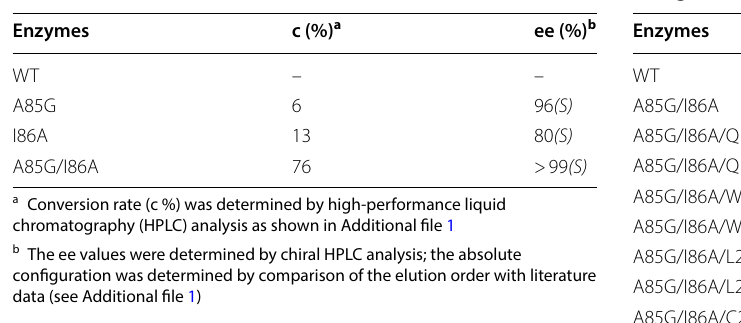
Table 2 Results of site-directed saturation mutagenesis